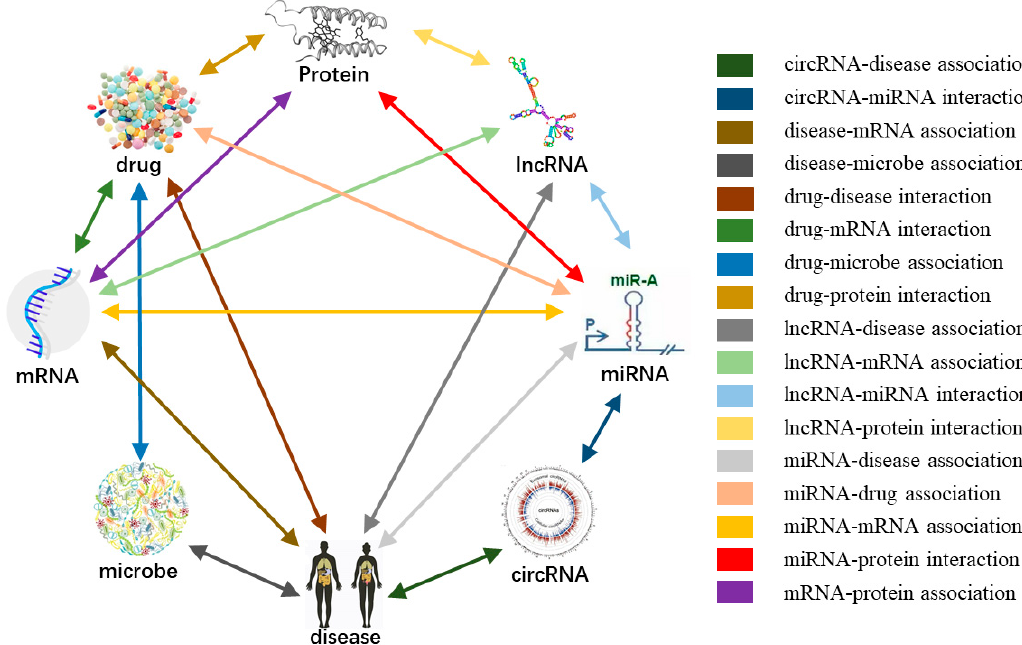
Figure 1. Example of the molecular association network. A different color represents different types molecule nodes and associations edges.